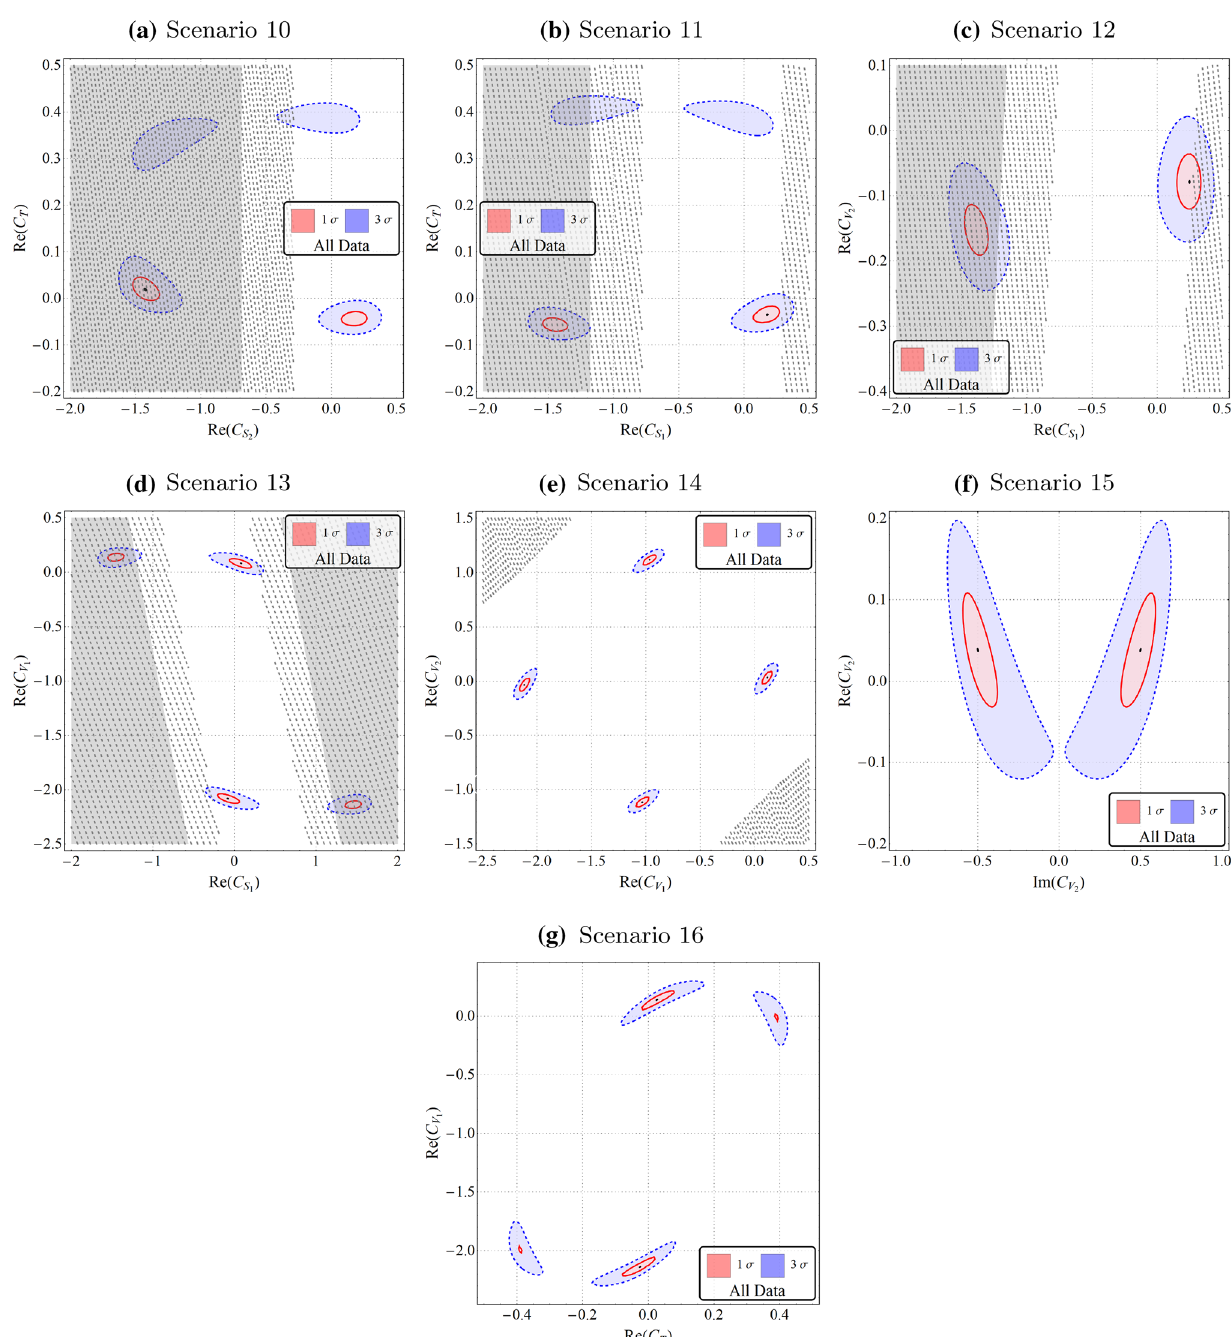
Fig. 2 Plots for the remaining scenarios, continued from Fig. 1